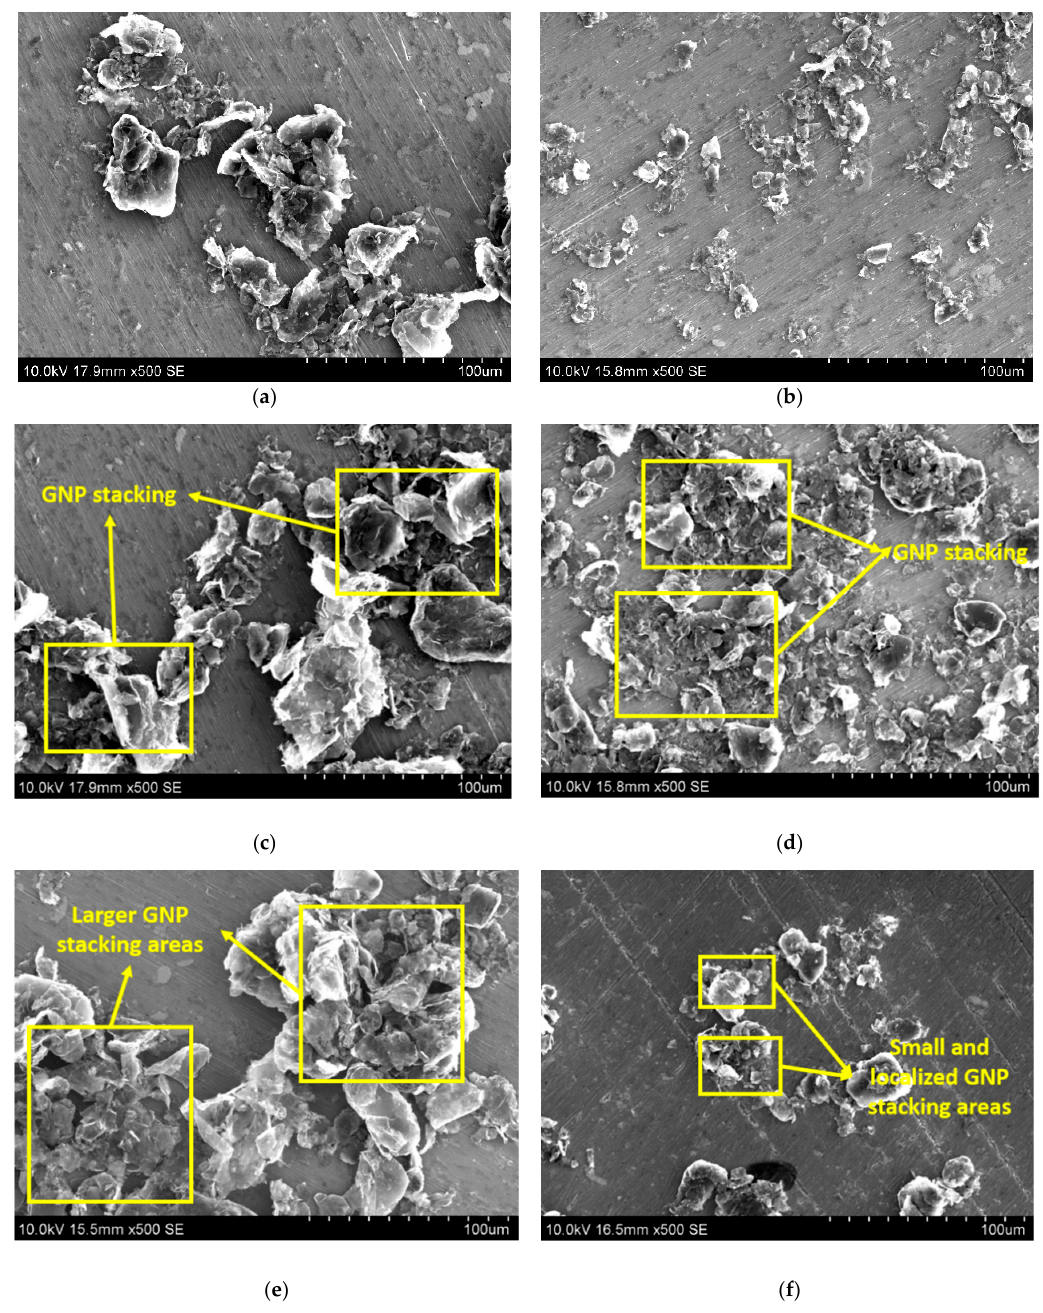
Figure 3. SEM images of GNP powder after the sonication process for ( a , c ) 5GNP-1 h, ( b , d ) 5GNP-3 h, ( e ) 8GNP-1 h, and ( f ) 8GNP-3 h samples.